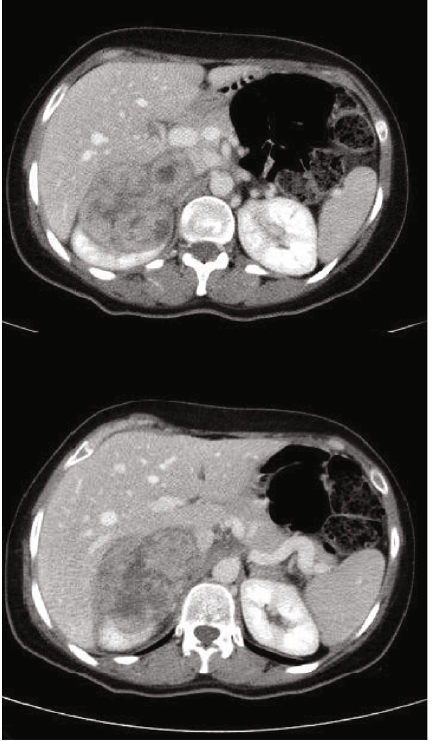
Figure 1: Axial CT views of the lesion, showing the involvement of the right kidney and IVC.